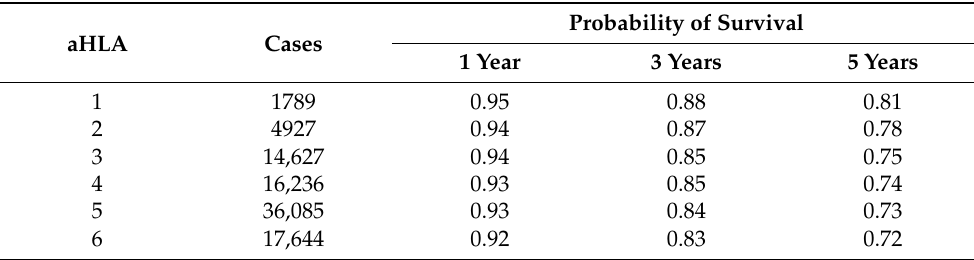
Table 2. Censored survival probability to renal graft failure at one, three and five years for UNOS from aHLA. Probability of Survival aHLA Cases 1 Year 3 Years 5 Years 1 1789 0.95 0.88 0.81 2 4927 0.94